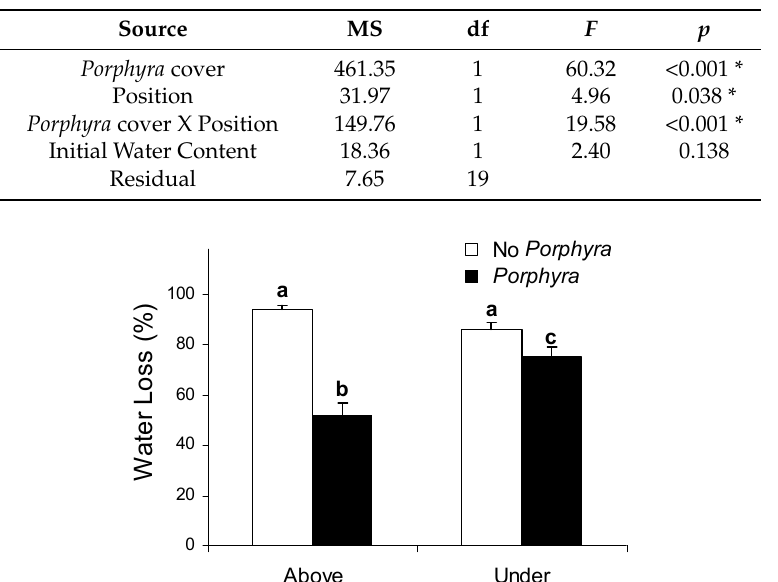
Figure 4. Mean (SE) water loss from water-saturate absorbent cloth pieces placed above and underneath the mussel layer in Porphyra -covered and exposed control areas. Cloth pieces were left in the field for three hours (11:00 a.m. to 2:00 p.m.) during a daytime, air exposure period (Low tide at 1:37 p.m.). Different letters above bars indicate significant differences.